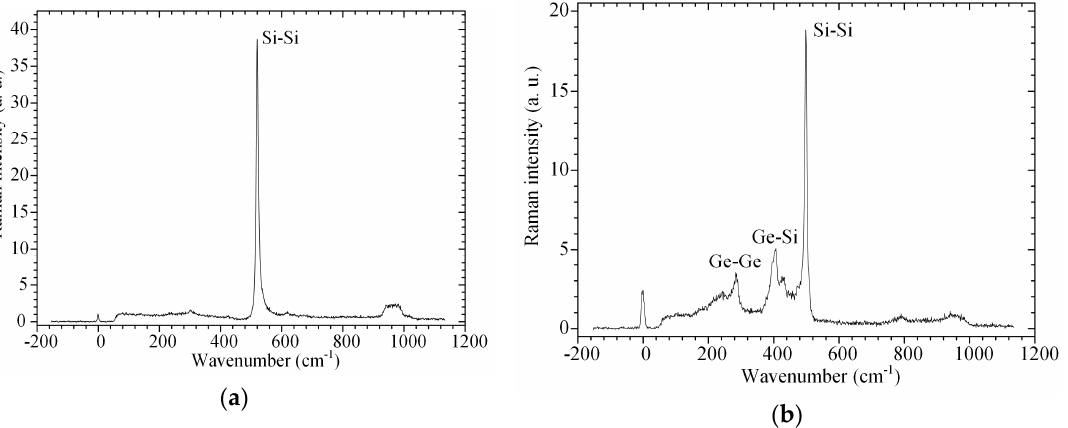
Figure 9. Raman spectra of ( a ) strained silicon (surface) and ( b ) germanium-silicon (cross-section). For the Raman measurement on the cross-section with a (110) crystal plane, the applicable Raman-mechanical relationship of (110) C-Si was given as Equation (2), where the residual stress is treated as a uniaxial stress state, because the normal component on the cross-section surface (denoted as σ x ) was released during the sample preparation, σ x = 0, σ y = σ and strain components ε x = ε y = ε , where x and y denote the in-plane directions [28].